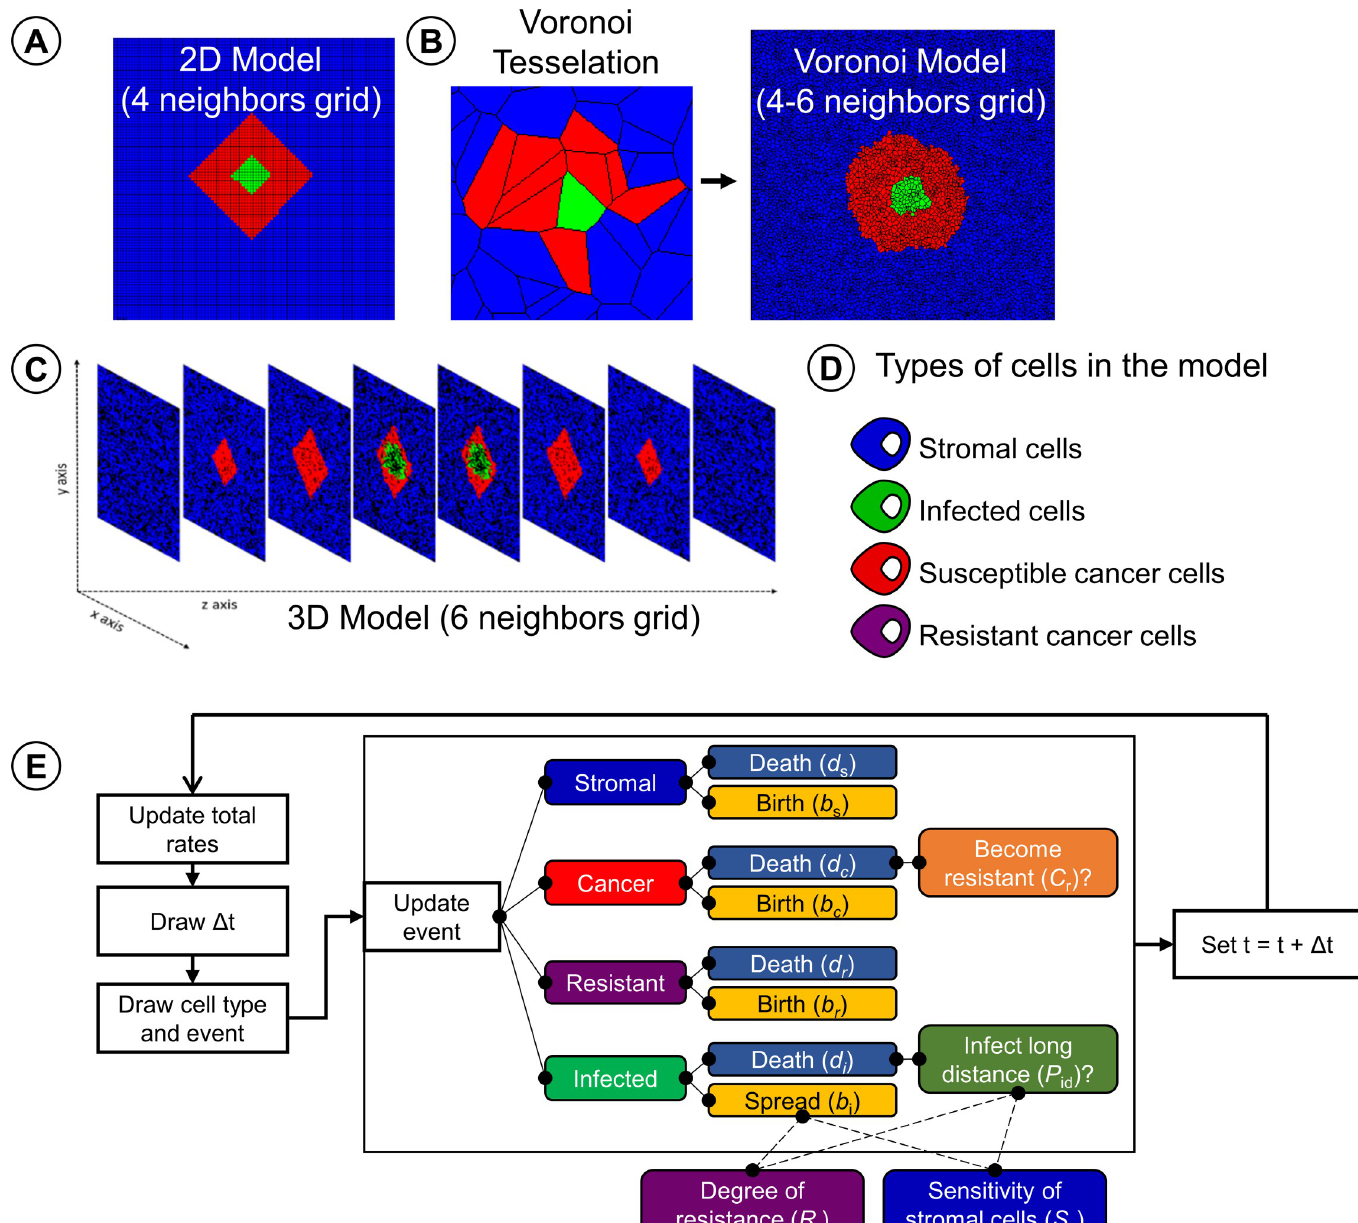
Fig 1. Visualization of the cell-based model variants. Spatial organization of (A) the 2-dimensional regular grid model, where each cell has 4 neighbours; (B) the 2-dimensional Voronoi grid model, where each cell has typically 4–6 neighbours; and (C) the 3-dimensional regular grid model, where each cell has 6 neighbours. (D) The four cell types in the model: stromal cells (blue), infection-sensitive cancer cells (red), virus-infected cancer cells (green) and resistant cancer cells (purple). (E) Schematic representation of the event-based model governing the dynamics of virus-cell interactions in the model.